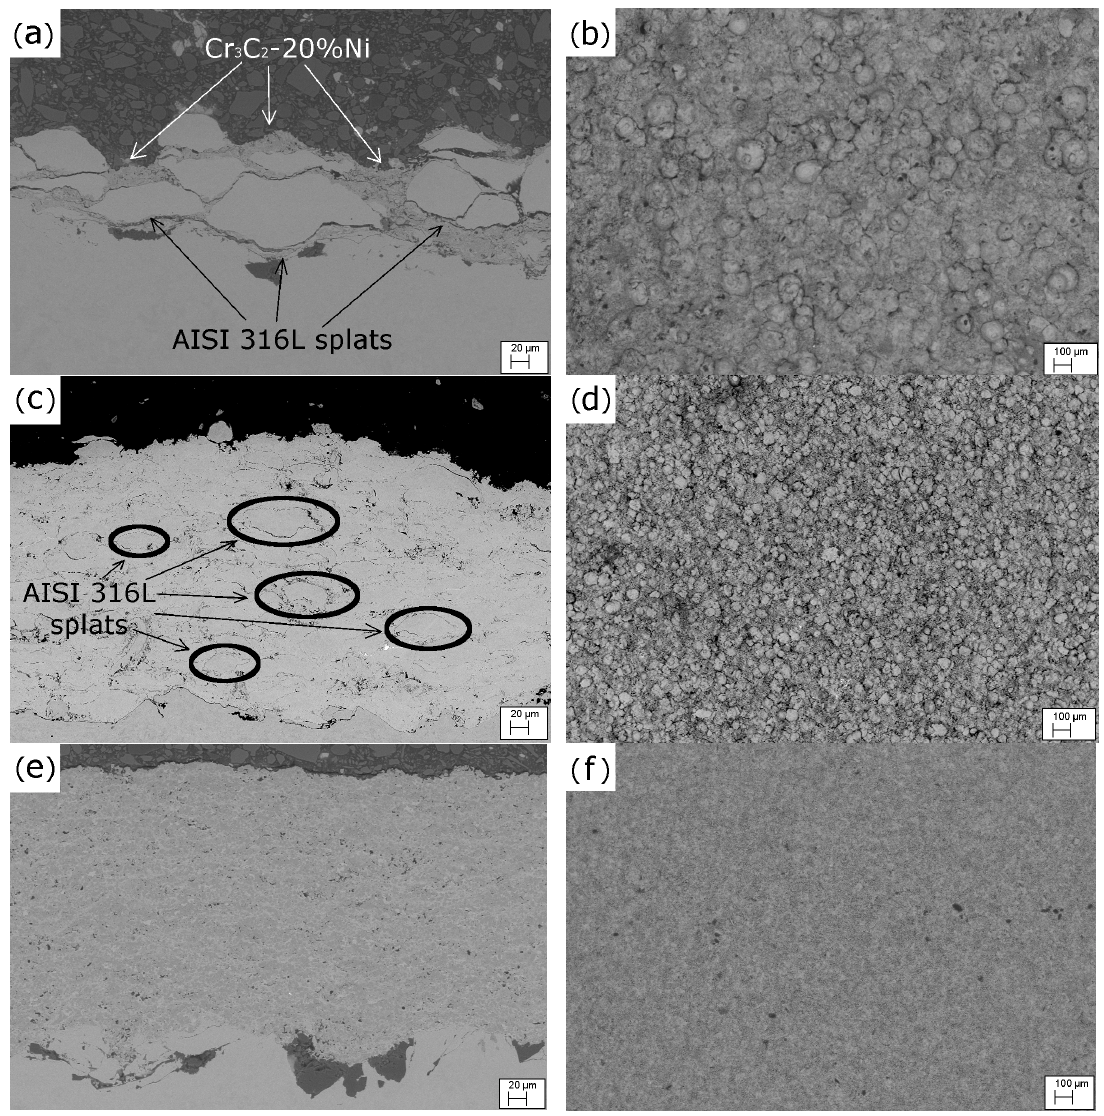
Figure 3. Microstructure (left column) and surface images (right column) of high velocity oxy fuel (HVOF) sprayed coatings: ( a , b ) MAS (Cr 3 C 2 –20%Ni) + AISI 316L; ( c , d ) AISI 316L (commercial); ( e , f ) Cr 3 C 2 –25%NiCr (Amperit).